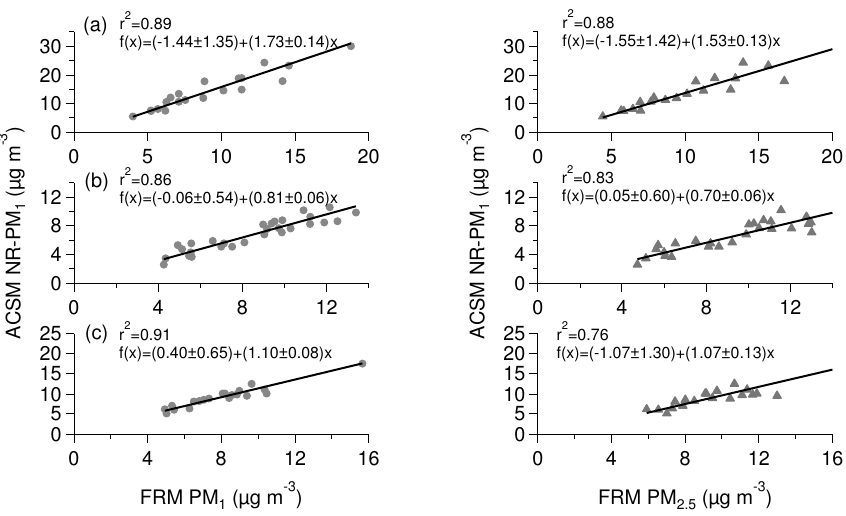
Figure 2. Correlation of ACSM NR-PM1 measurements with those of FRM PM 1 and PM 2 . 5 methods during (a) winter, (b) spring, and (c) summer 2012,